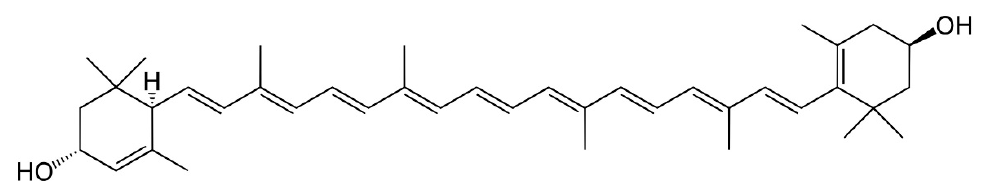
Figure 1. Structure of lutein